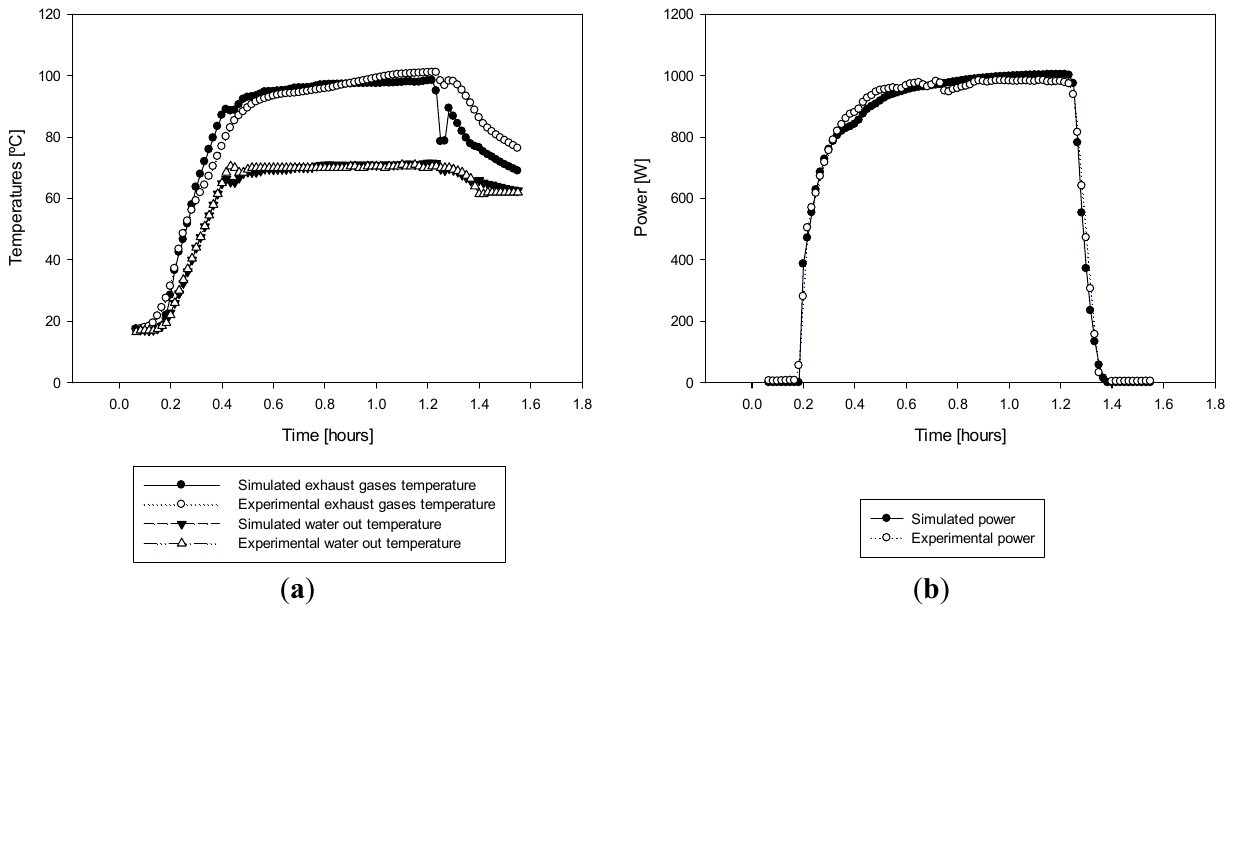
Figure 10. ( a ) Simulated and experimental outlet water temperature and exhaust gases temperature for T = 60 °C; ( b ) Simulated and experimental power for T set